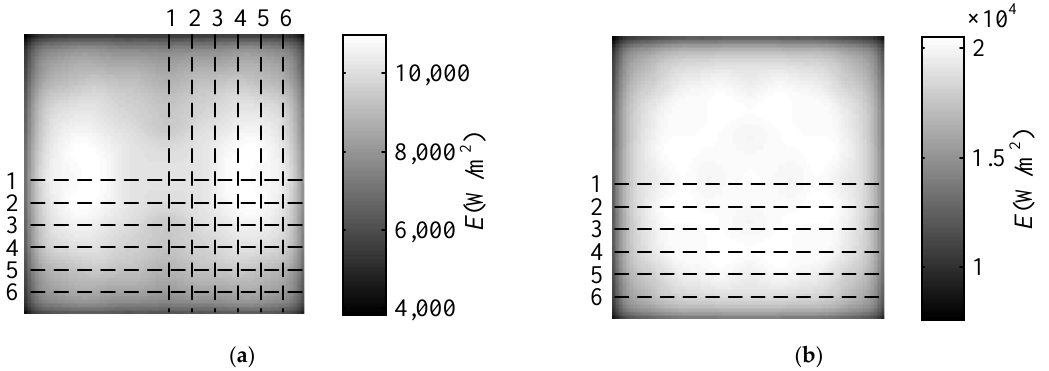
Figure 8. TracePro simulation irradiance distribution map. ( a ) Uncrossed; ( b ) cross-optimization.